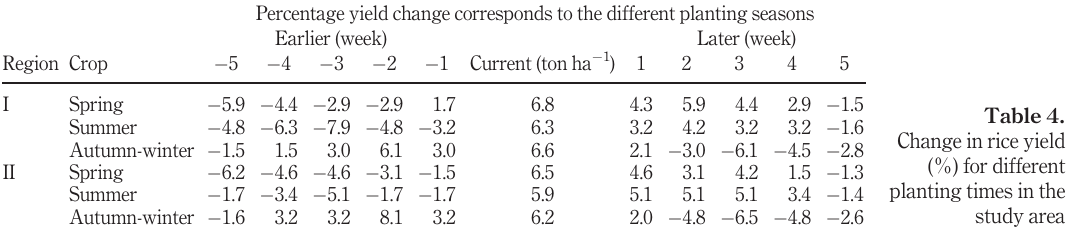
Table 4. Change in rice yield (%) for different planting times in the study